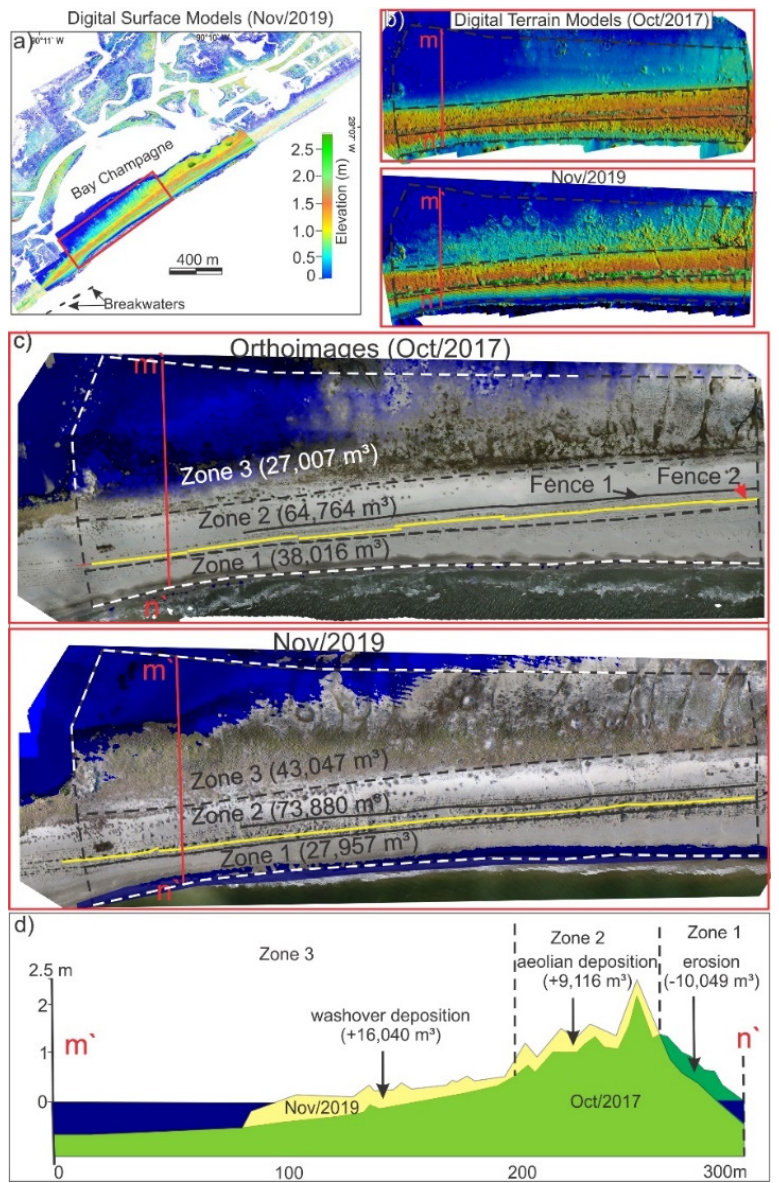
Figure 6. ( a ) Digital terrain model of the study area (Nov/2019), ( b ) comparative analysis between the digital terrain models of Oct/2017 and Nov/2019, ( c ) Orthoimages of Oct/2017 and Nov/2019 with comparative analysis of the sedimentary volume of the zones 1 (part the supratidal and sandy intertidal flat under the action of currents and waves), 2 (part of the supratidal), and 3 (part of the supratidal and the intertidal flat behind the coastal barrier) along the beach barrier between 2017 and 2019, ( d ) and a planialtimetric cross-shore profile based on drone data. Margins of error are ± 0.15 m (vertical) and ± 0.076 m 3